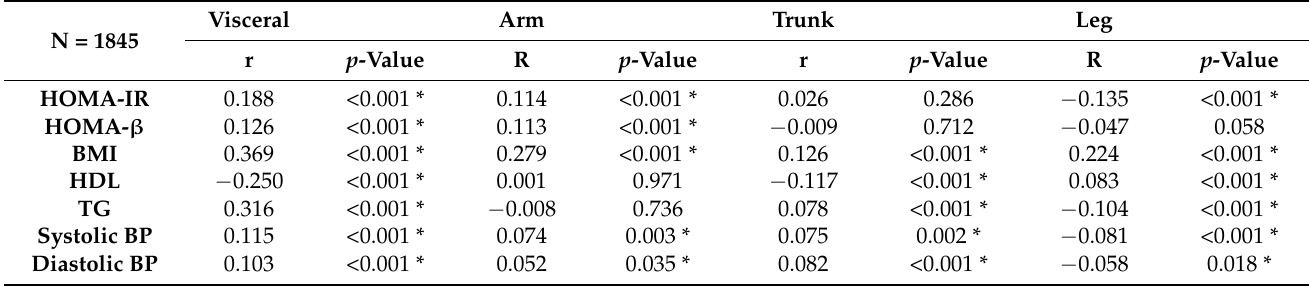
Table 6. Associations between regional adiposity and metabolic characteristics in women.